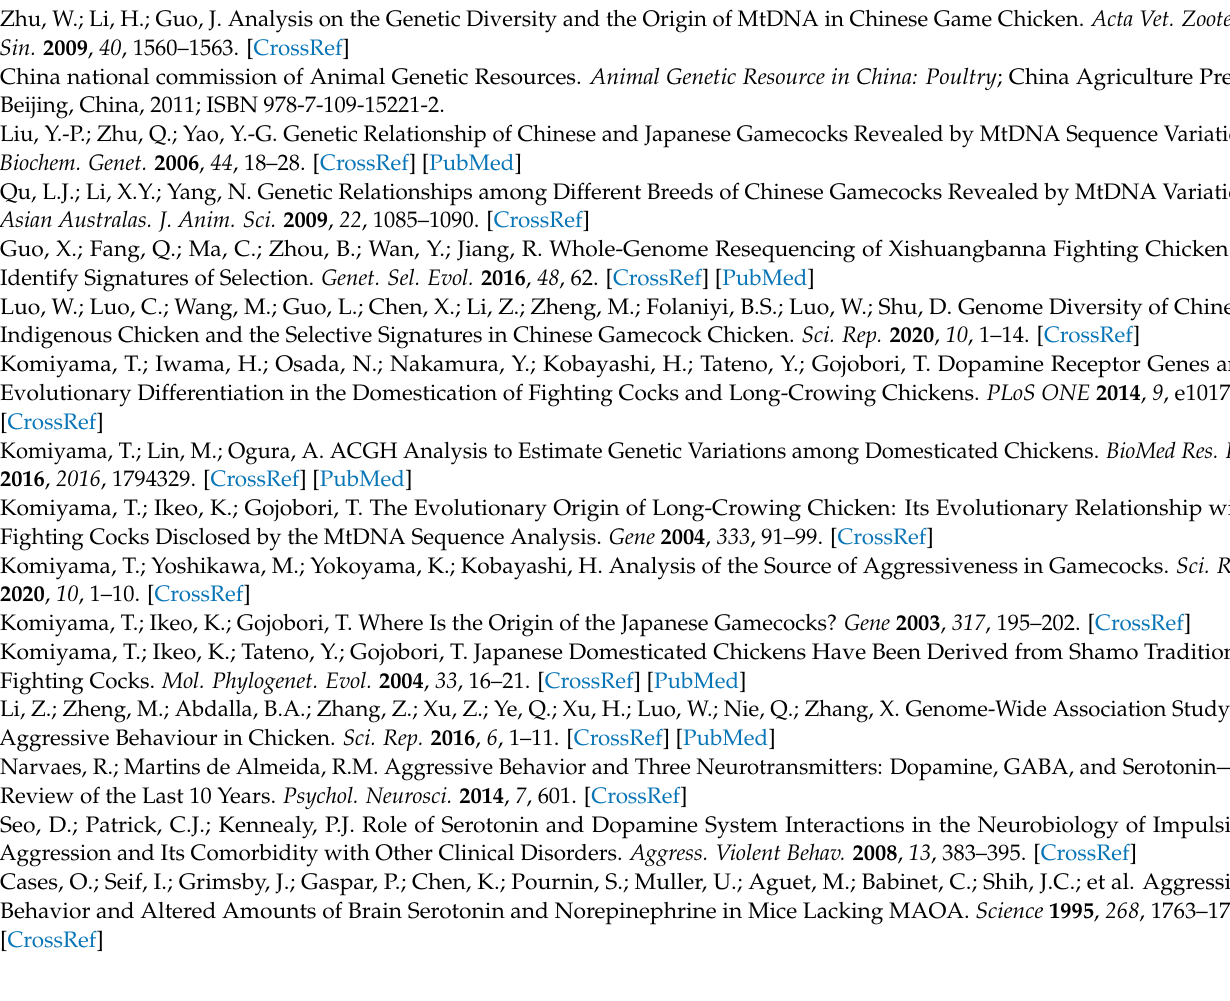
Table S4: Information of all significant DEGs for each comparison. Table S5: A list of genes shared by selective sweeps and